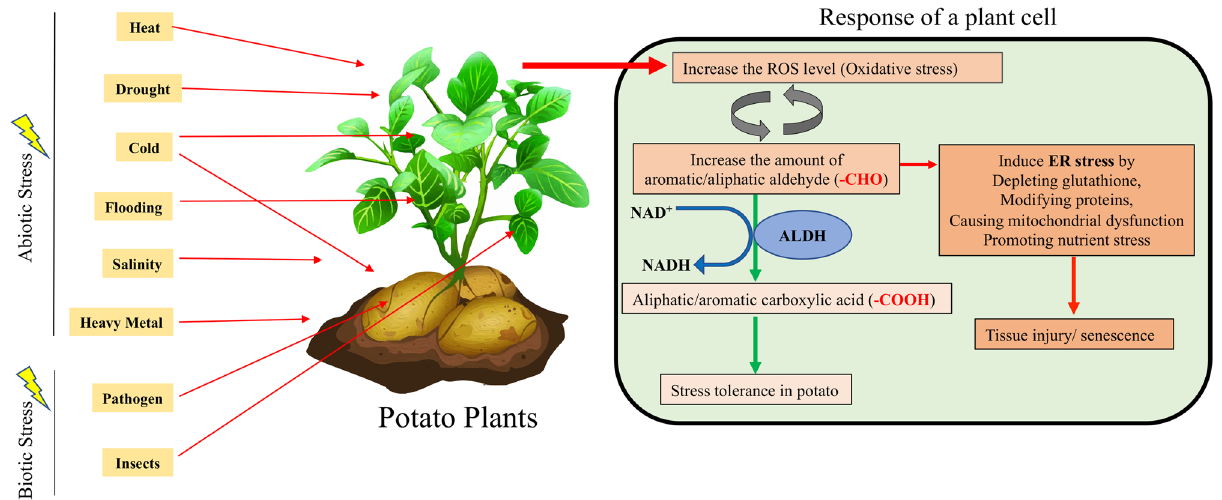
Figure 9. Illustration of the possible role of StALDH in aldehyde detoxification under stress conditions. Different abiotic (heat, cold, salinity, drought, flood, heavy metal) and biotic (pathogen and insects) stresses affect various part of potato plants and induce intercellular reactive oxygen species (ROS) accumulation. ROS in turn forms a vicious cycle by forming reactive aldehydes that could be either detoxified by ALDH or resulted in tissue degeneration. The figure was generated using Adobe Illustrator (https:// www. adobe. com/ produ cts/ illus trator.